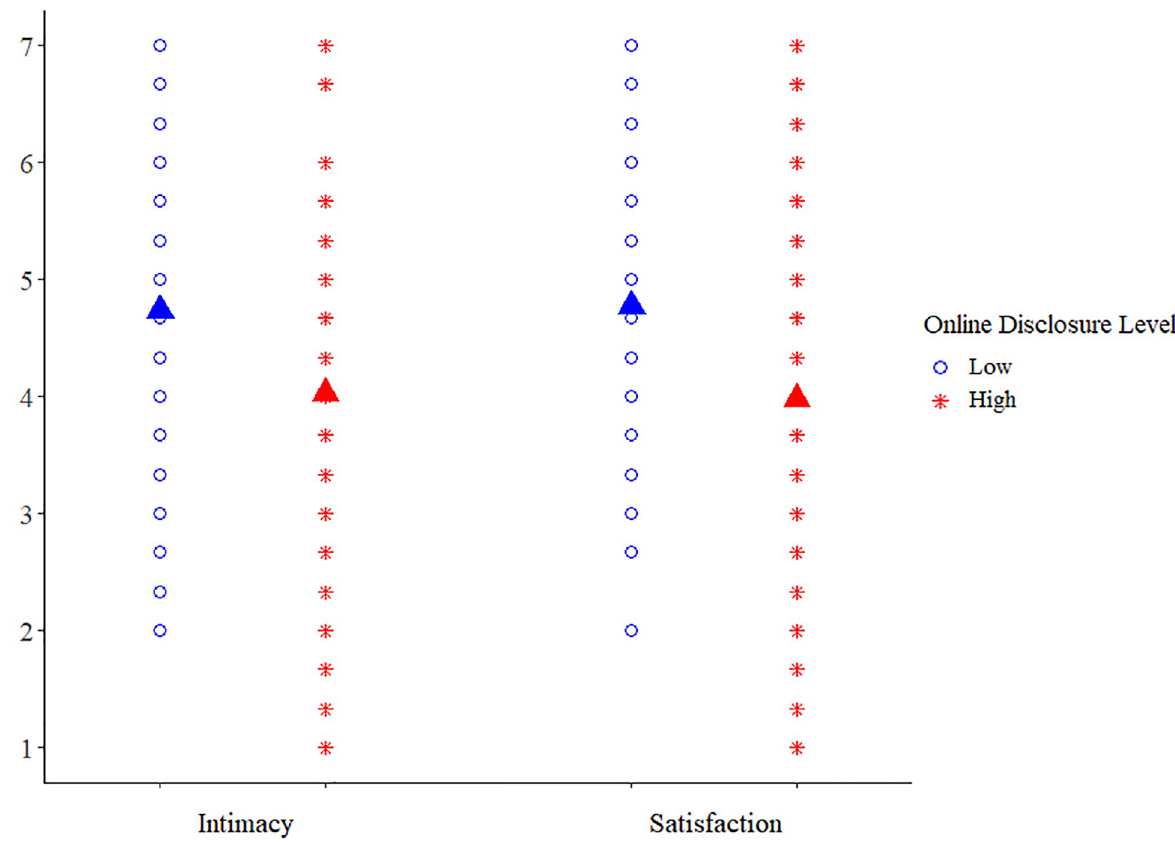
Fig 1. Study 3 means for intimacy and satisfaction in each of the prime conditions.